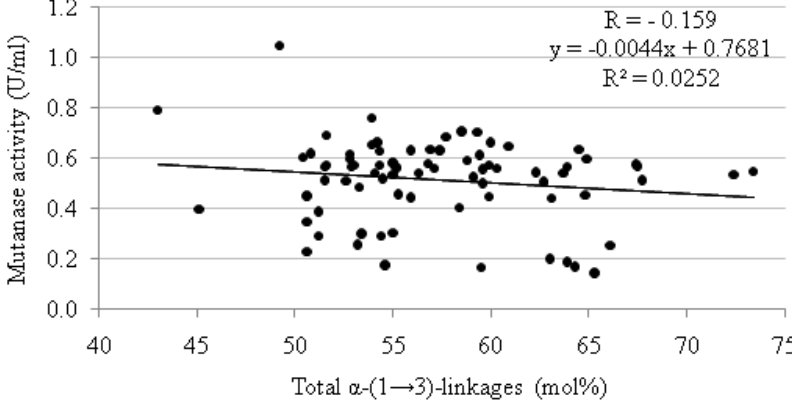
Figure 2. Relationship between mutanase activity obtained on particular mutans as enzyme inducers (76 samples) and the total content of α -(1 → 3)-linkages in each of these polymers (for details see Table 4). The data obtained from statistical analysis: Pearson correlation (R), determination (R 2 ), and linear regression (y), p <